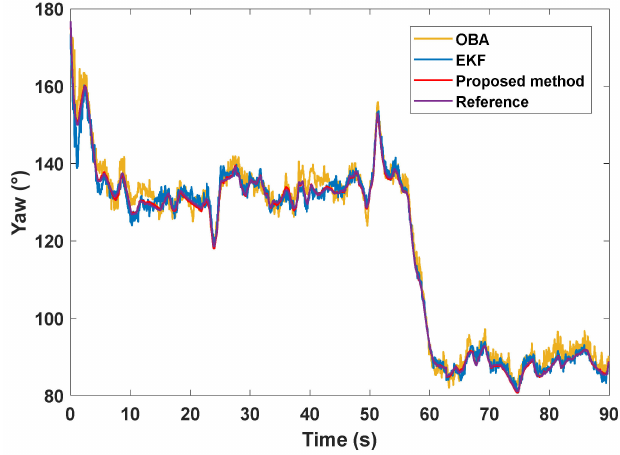
Figure 15. Real time yaw angle estimation curves of three different IFA methods.